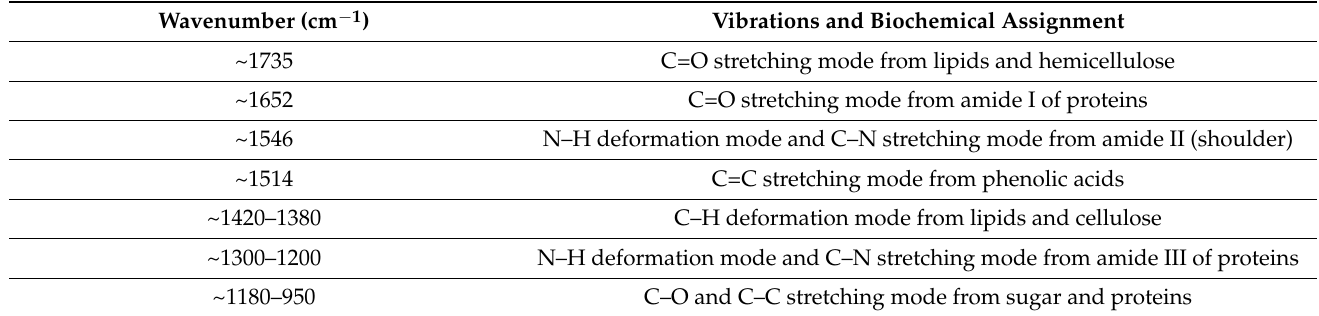
Table 2. Meaningful peaks in FTIR spectra of pollen samples; wavenumber (peak position) and corresponding vibrations and biochemical